Question: Summarize what this figure shows in one sentence.
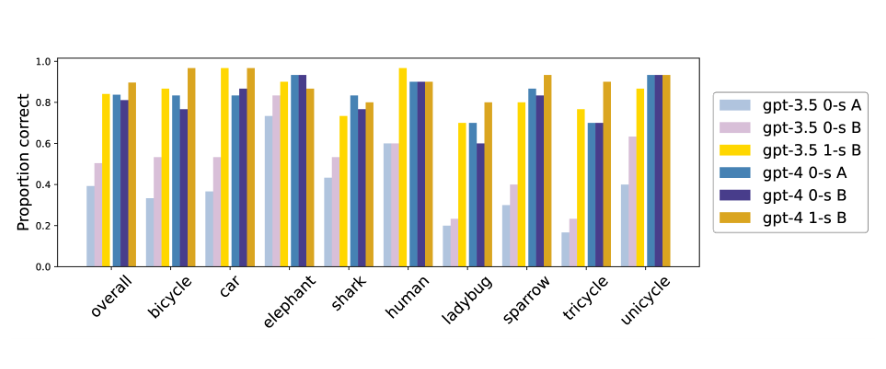
Answer: Proportion of correct answers on numerical facts, by subject. For each subject the same set of elements was probed, e.g. number of legs, tyres, fins etc.